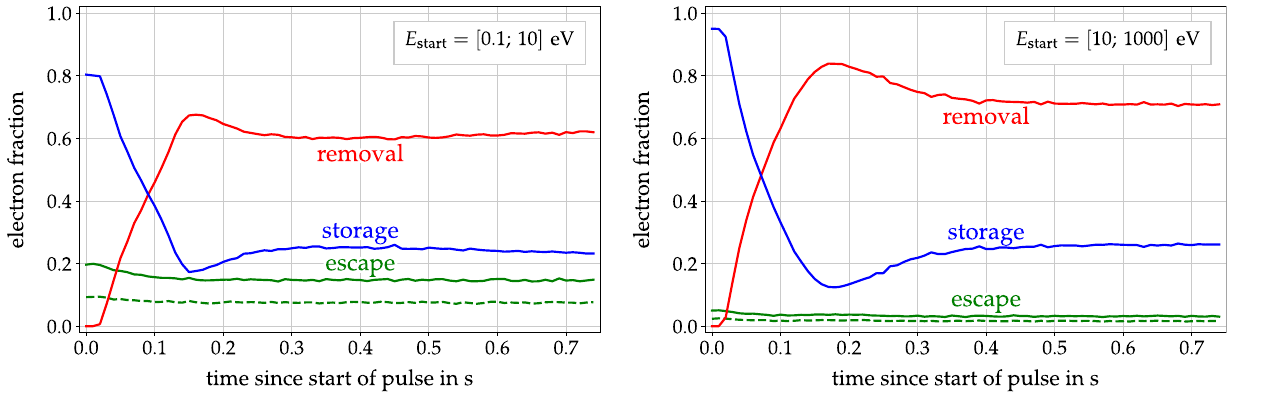
Fig. 9 Simulated electron storage conditions in different energy regimes during a magnetic pulse cycle. The plots show the fraction of removed,stored,andescapingelectrons(solidlines)fromatotalamount of 25000 electrons created randomly inside the nominal flux tube vol- ume. Left: conditions for low-energy electrons 0 . 1 eV ≤ E start ≤ 10 eV. Right: conditions for high-energy electrons 10 eV ≤ E start ≤